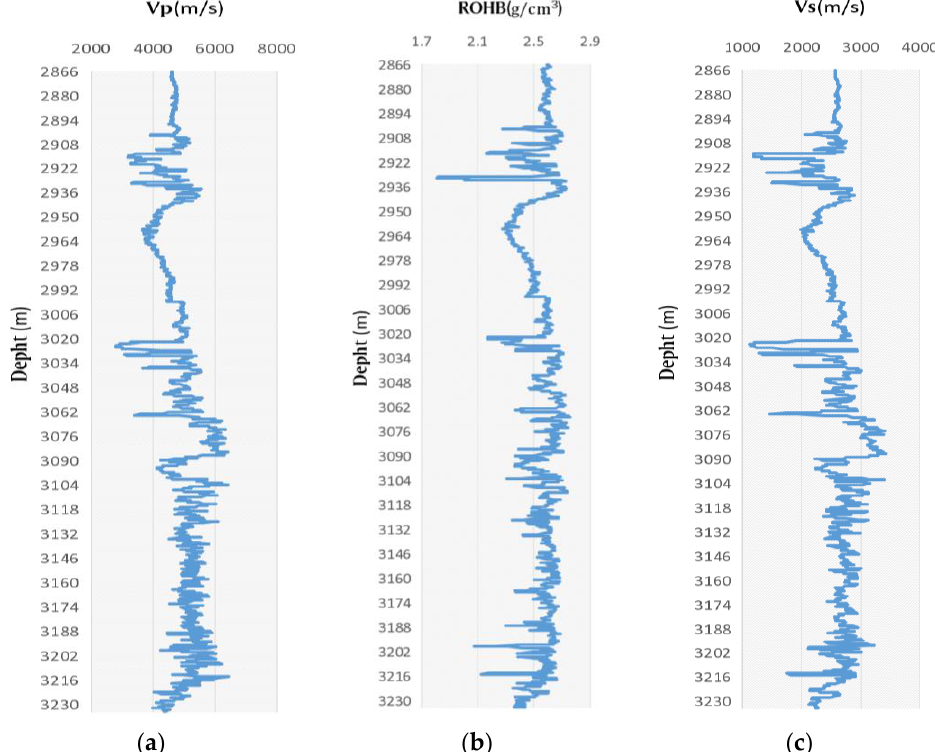
Figure 3. Well-logging data for input parameters in the study area ( a ) V P ; ( b ) RHOB; and ( c ) Vs.